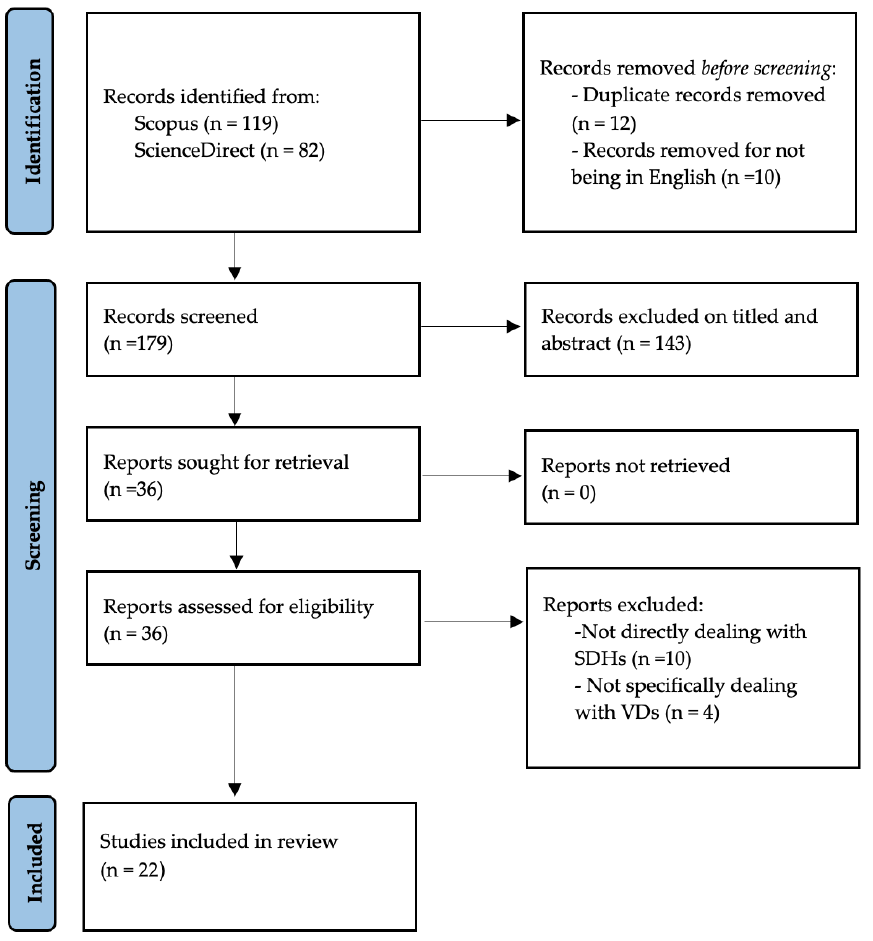
Figure 1. Prisma 2020 Flow Diagram.